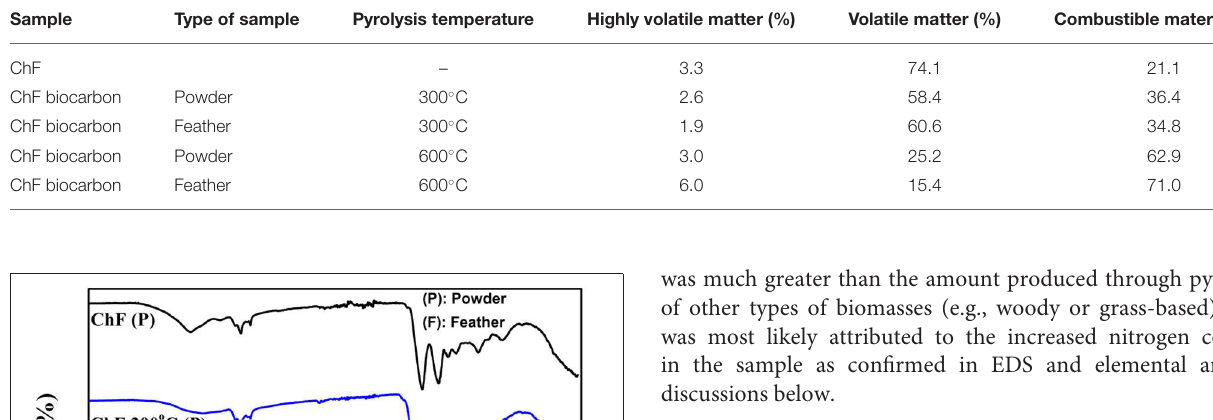
TABLE 3 | Volatile and combustible materials for ChF biocarbon as determined by TGA analysis.